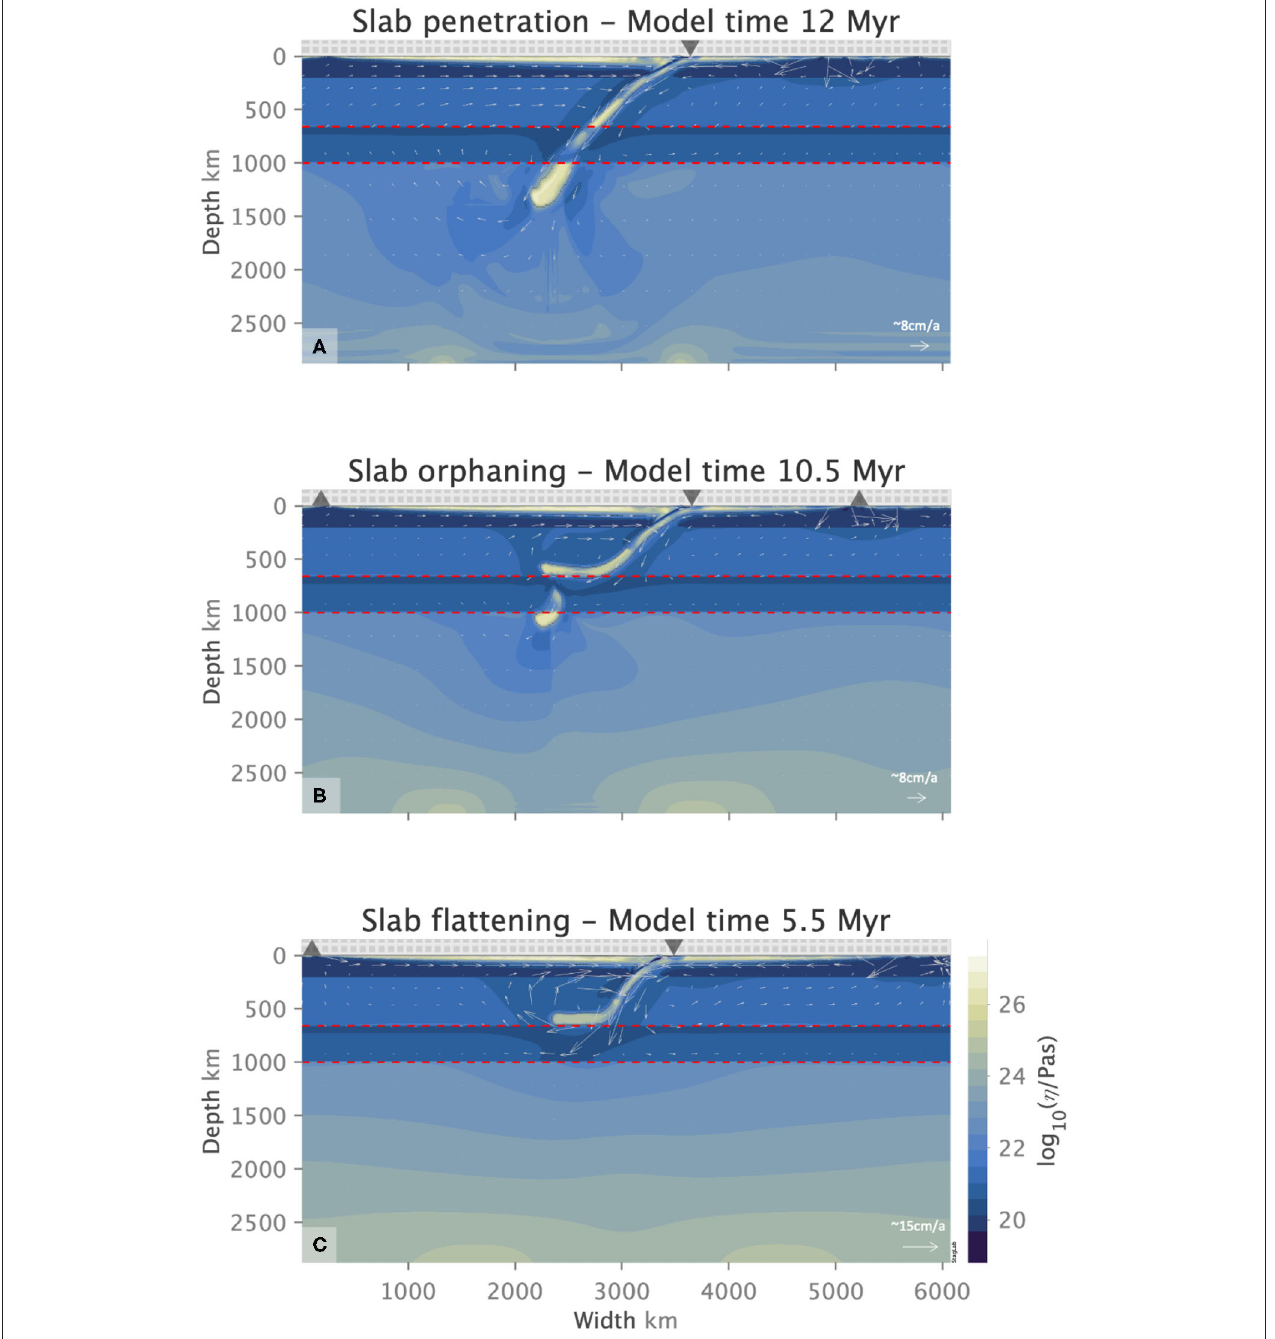
FIGURE 5 | Penetrative (A) , orphaning (B) , and flattening (C) behavior for a slab with a yield stress value of 400 MPa, the subduction of which is being offset by Clapeyron slope values of 1.5, 2.0 and 2.5 MPaK − 1 , respectively. Sharp changes in the lower mantle viscosity underneath the slab tip are caused by sudden − − − changes in the stress field. This is due to a heavy slab that is cold and therefore very viscous, subducting into the lower mantle where the viscosity is still stress-dependent due to dislocation creep. Orphaning occurs at the top of the lower mantle and is unaffected by the deeper lower mantle behavior. Flow arrows indicate the sense of flow direction and its relative magnitude for each figure.